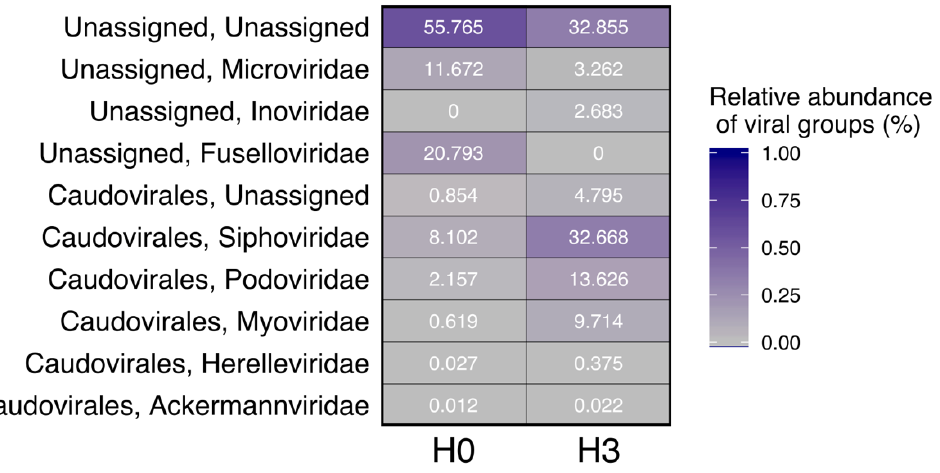
Figure 3. Viral taxonomy heatmap generated with VIBRANT.